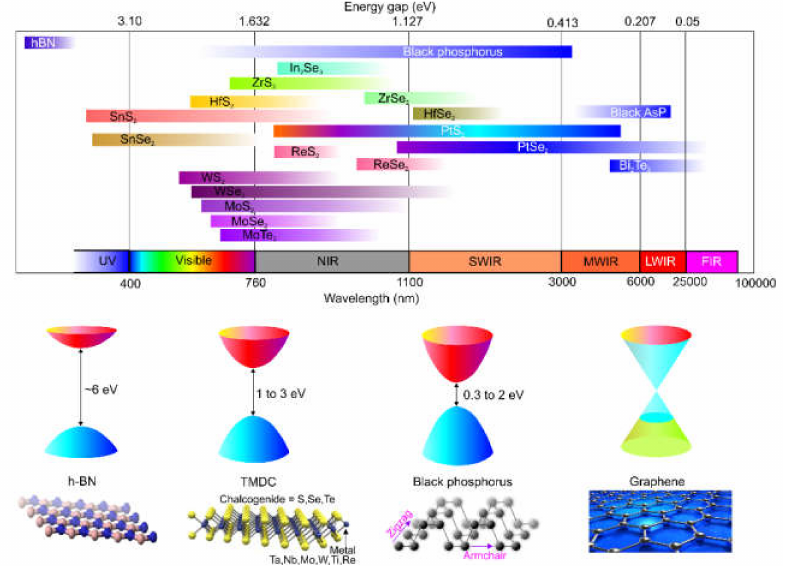
Figure 13. Energy bandgap of the selected layered semiconductors versus wavelength. The energy bandgap exhibits the dependence on the layers number, strain level and chemical doping. FIR— Far infrared; LWIR—Long wavelength infrared; MWIR—Mid wavelength infrared; SWIR—Short wavelength infrared; NIR—Near infrared;